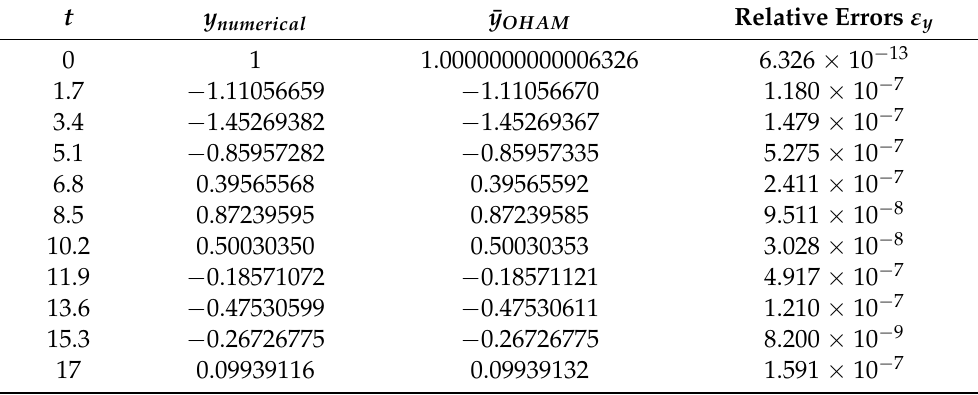
(cid:12) (cid:12) (cid:12) y numerical − ¯ y OHAM (cid:12)